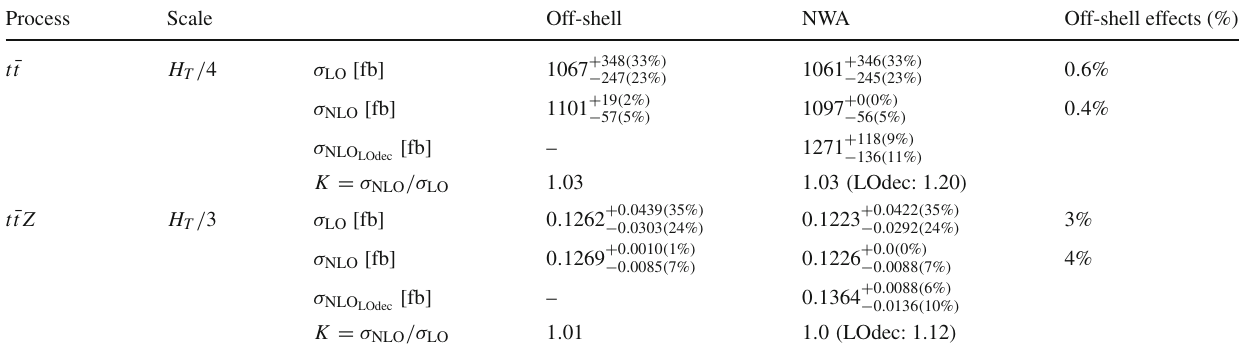
with the NLO CT14 PDF set for the LHC with center of mass energy √ s = 13 TeV. The lower panels depict the ratio to the distributions for = E / 3 m Y = 1 TeV T 0 √ s = 13 TeV. We employ the (N)LO CT14 PDF set. of mass energy of For the K -factor in the NWA we give the values for the full NLO NWA result and the one with LO decays, the latter in parenthesis